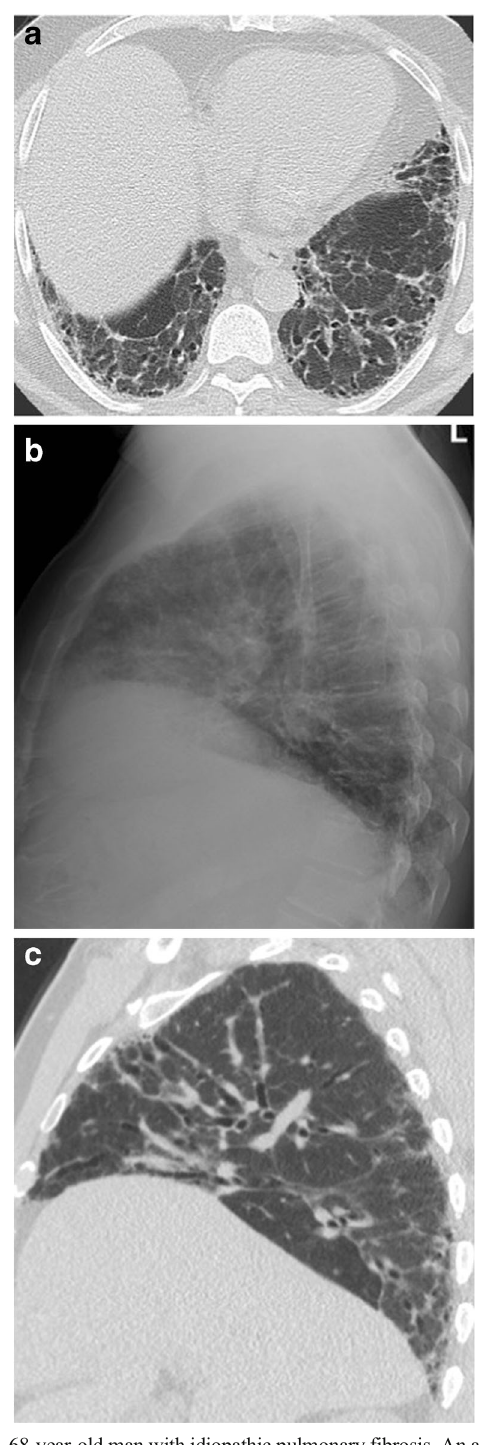
Fig. 4 68-year-old man with idiopathic pulmonary fibrosis. An axial CT slice (a) shows fibrosis at the lung bases. On the lateral radiograph (b), reticular opacities are seen in the retrosternal clear space but not at the lung bases, where they are obscured by pulmonary vasculature and the spine. A corresponding sagittal CT slice (c) is also shown